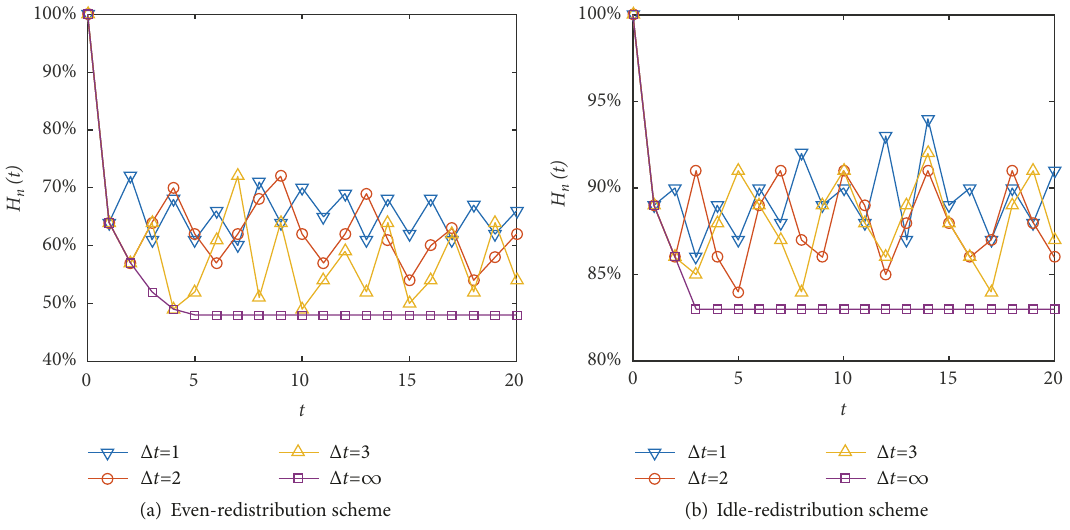
Figure 11: Survival ratio with varying Δ𝑡 ( 𝛼 = 𝛽 = 1